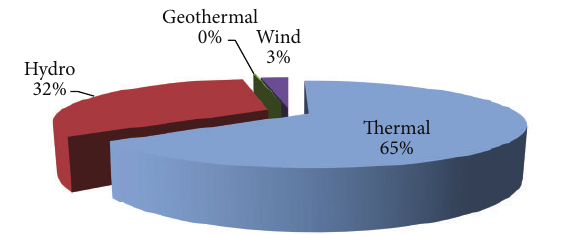
Figure 3: Distribution of installed power capacity of Turkey.